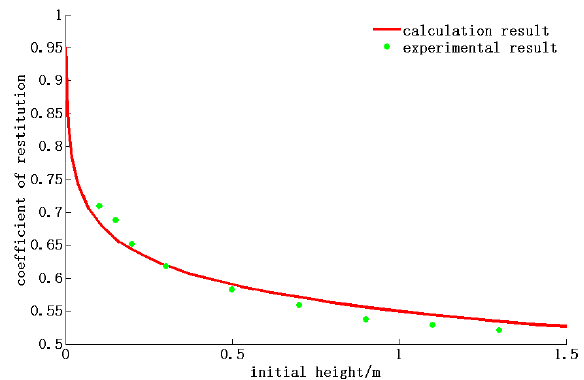
Figure 11. Comparison of the calculation results and experimental results.